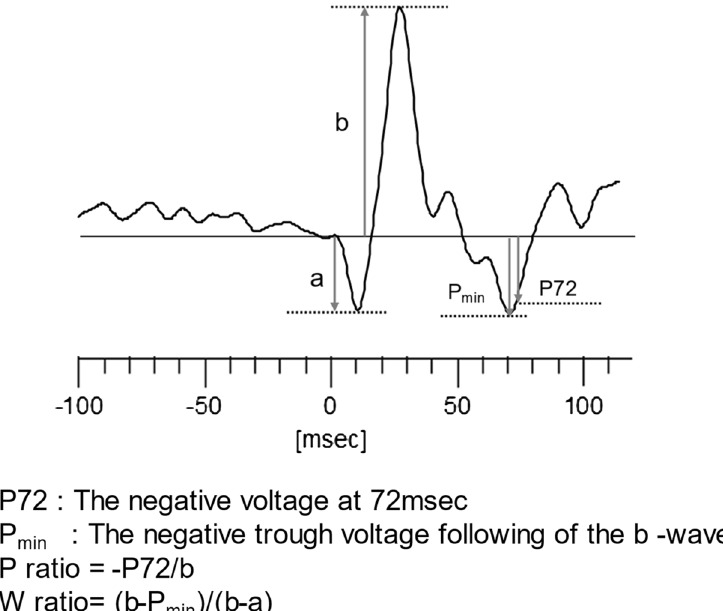
Figure 4. Illustration of the methods to measure various components of the ERG waveform. Arrows represent the amplitude of each parameter. The a-wave amplitude was measured from the pre-stimulus baseline to the first negative trough (a). The b-wave amplitude was measured from the a-wave trough to the positive peak (b-a). The P72 amplitude was measured at 72 ms after the stimulus onset, and the amplitude of P min was measured at the negative trough following the b-wave. The calculation of P ratio and W ratio was done as shown in the